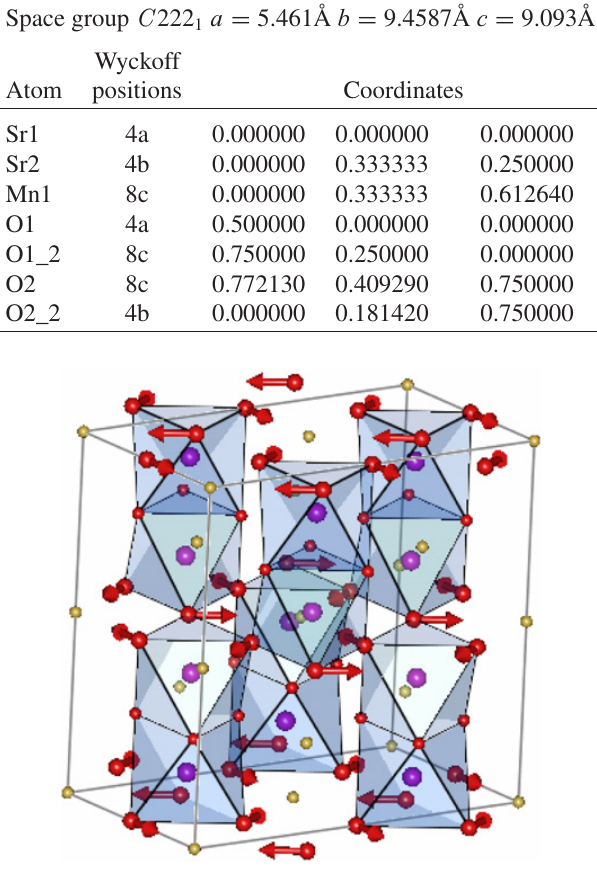
Table 8. Reference structure for the irrep distortions in the C 222 1 phase of SrMnO 3 .